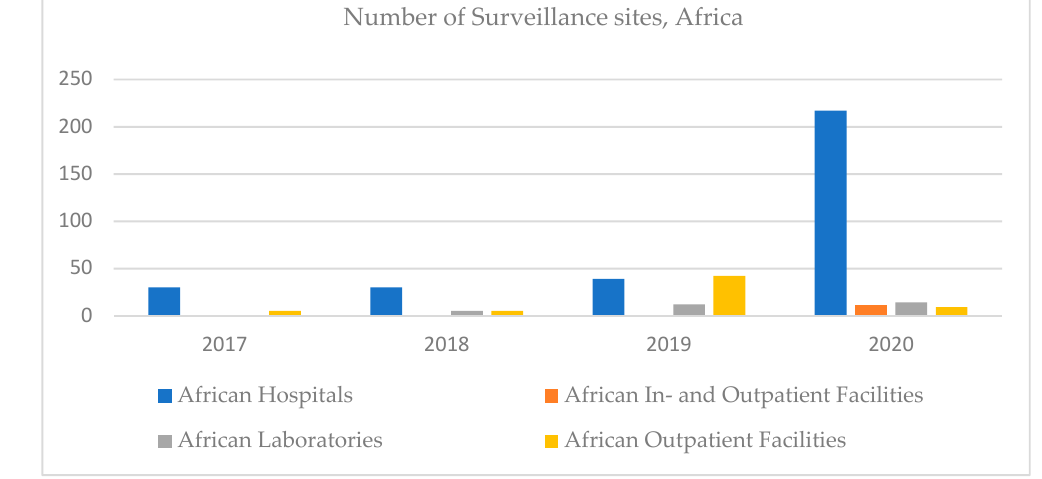
Figure 4. Number of surveillance sites, Africa, 2017–2020.